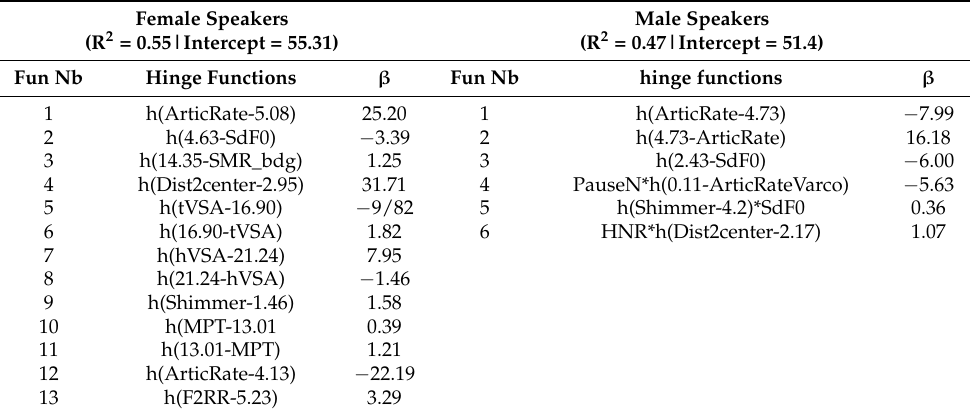
Table 4. Summary of analysis 2, testing how age is modelled by the 22 speech descriptors, for female (left panel), and for male (right panel) speakers: hinge functions and corresponding slope estimate values ( β ).